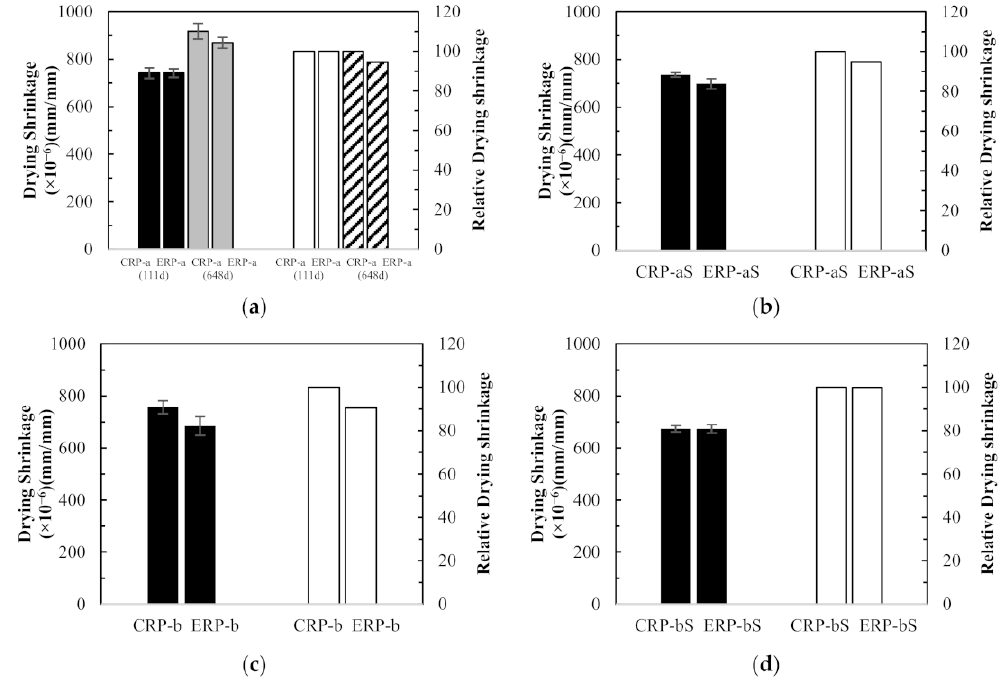
Figure 9. Concrete drying shrinkage results and relative values between different mix design method: ( a ) CRP-a versus ERP-a, ( b ) CRP-aS versus ERP-aS, ( c ) CRP-b versus ERP-b, and ( d ) CRP-bS versus